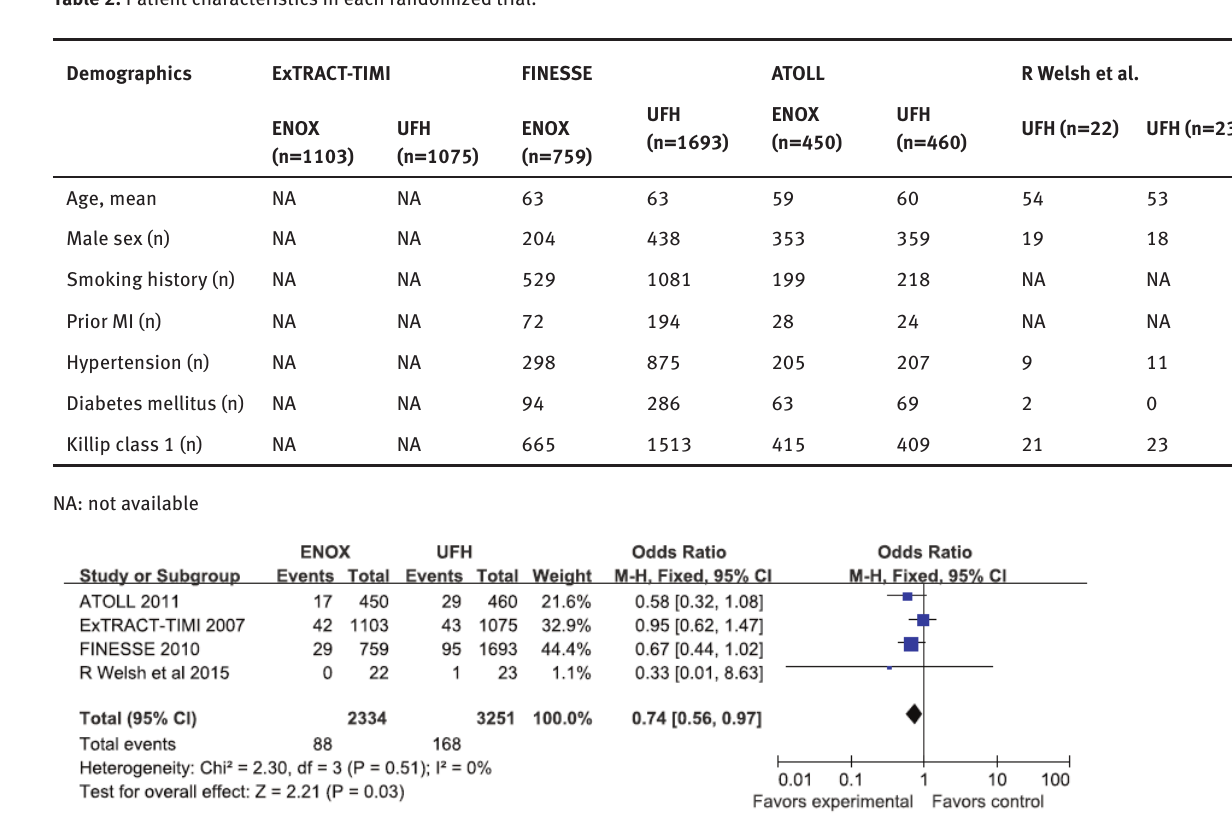
Figure 2: Fixed-effect meta-analysis for death. The figure presents the number of events, the number of patients in the treatment and control groups, the odds ratio (OR) and 95% confidence interval (CI) for each trial, the overall OR estimate with 95% CI and the P value for the asso- ciation test, the P value for the heterogeneity test, and between-trial inconsistency (I2) measures.